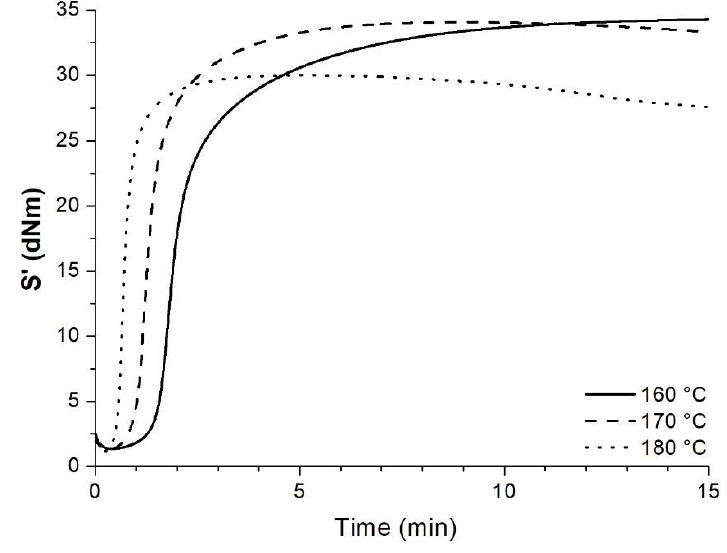
Figure 1. Vulcanization curves of the MR at different temperatures.